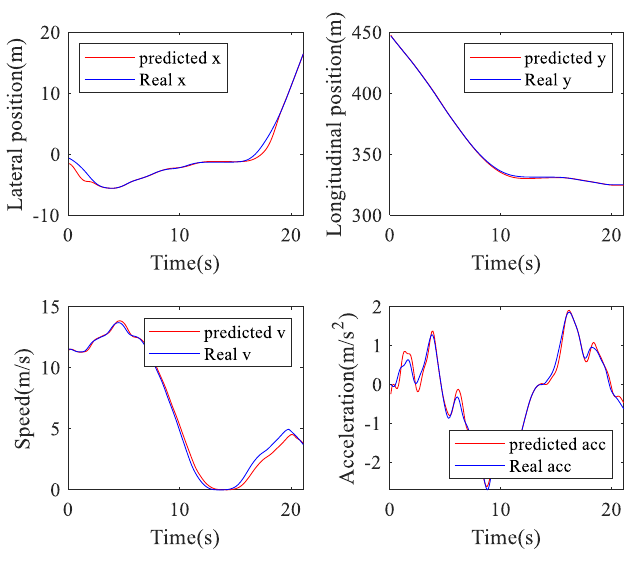
Figure 12. Turn left prediction.